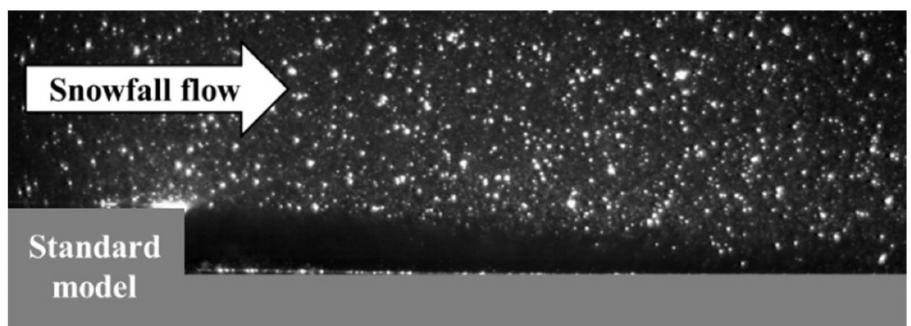
Figure 21. Snow behavior photographed by the high-speed camera.